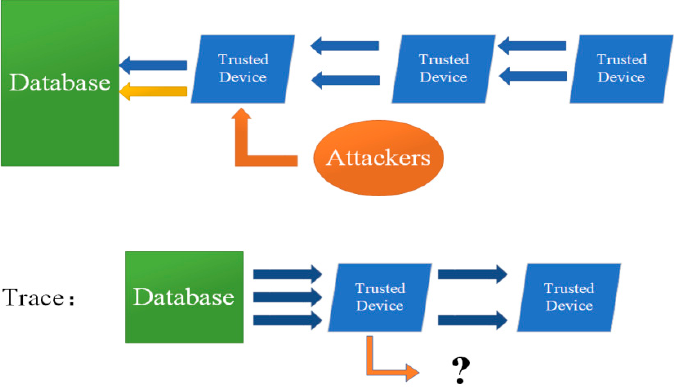
Figure 1. Traced